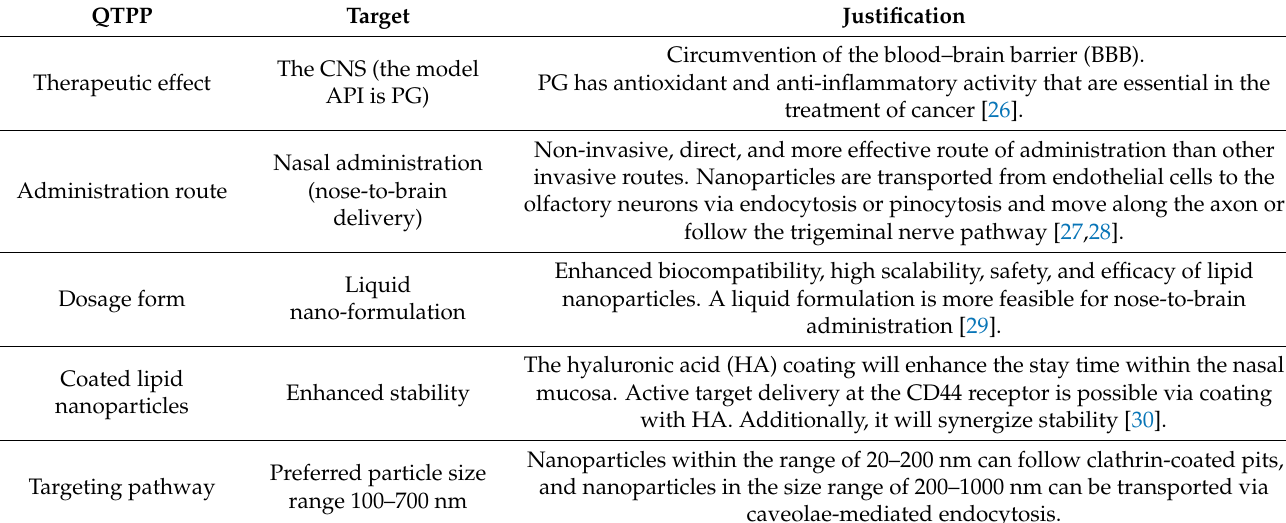
Table 1. Selection of quality target product profiles (QTPPs) of PG-loaded liposomes for nose-to-brain delivery, along with respective target and justification.